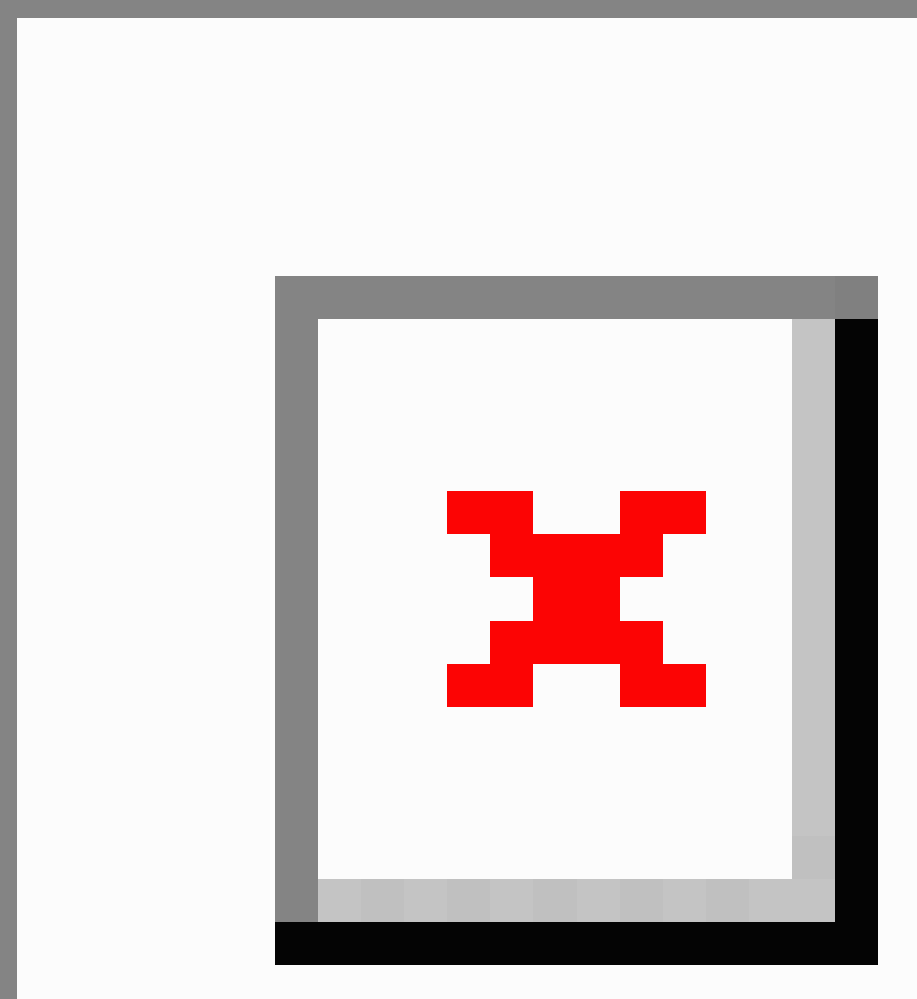
Figure 1. Screenshot from the Diabit portal. Home ”Welcome to